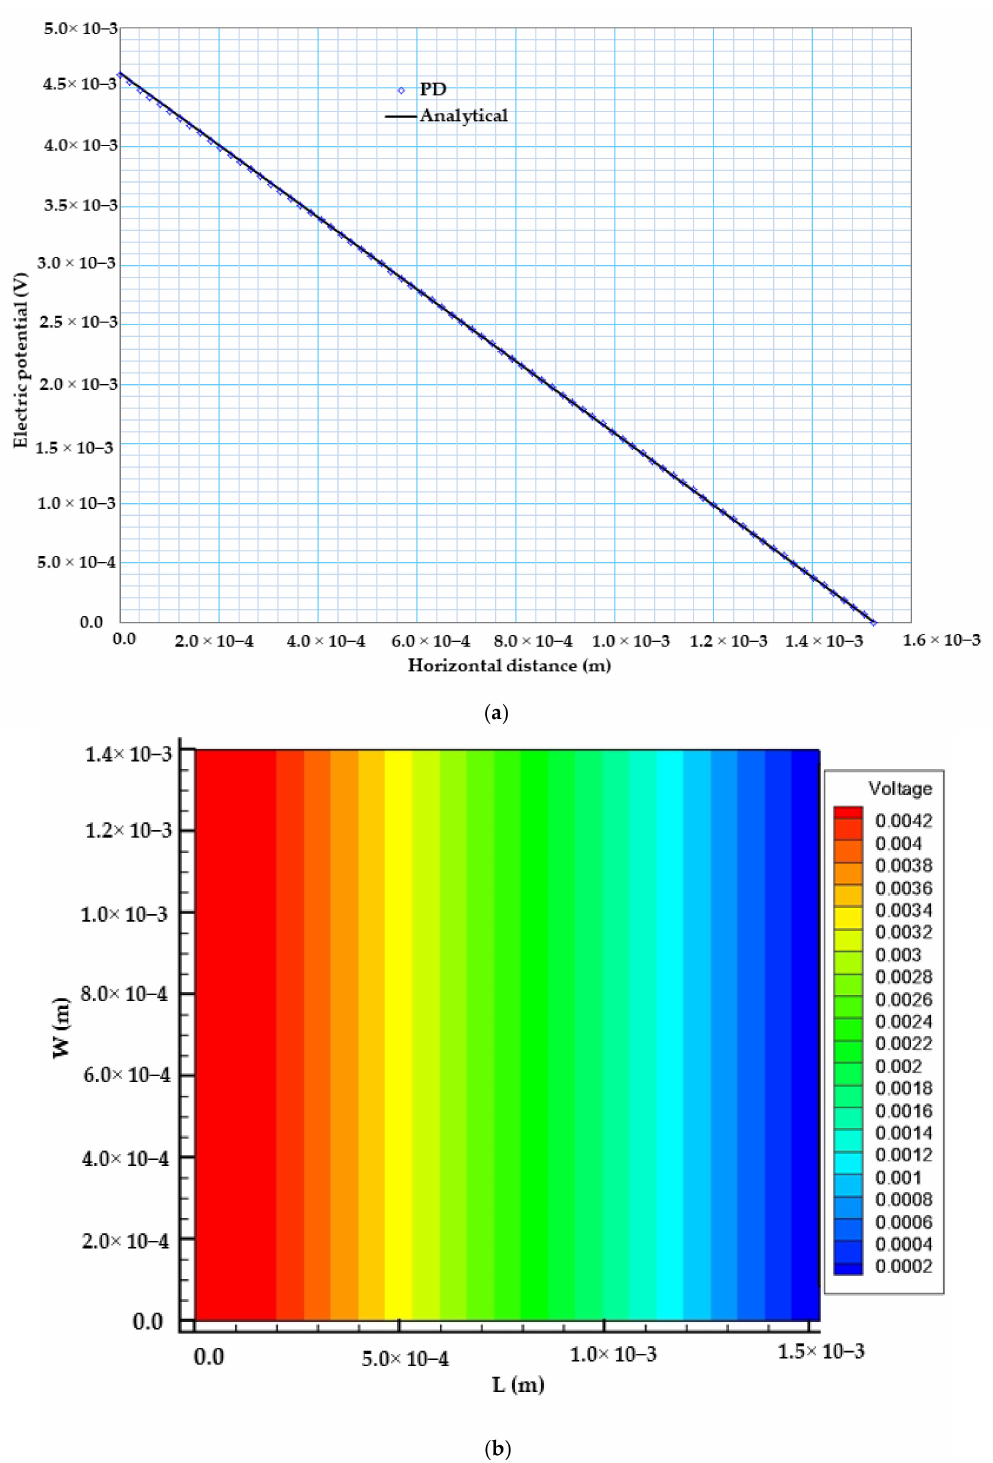
Figure 8. ( a ) 2D electric potential variations from PD and analytical solutions for constant material properties. ( b ) Electric potential distribution of bismuth telluride